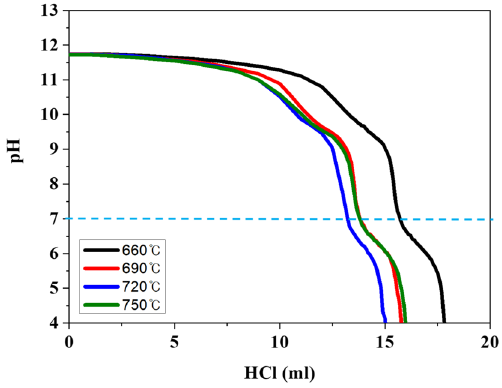
Figure 7. HCI-titration curves NCA with various sintering temperatures.